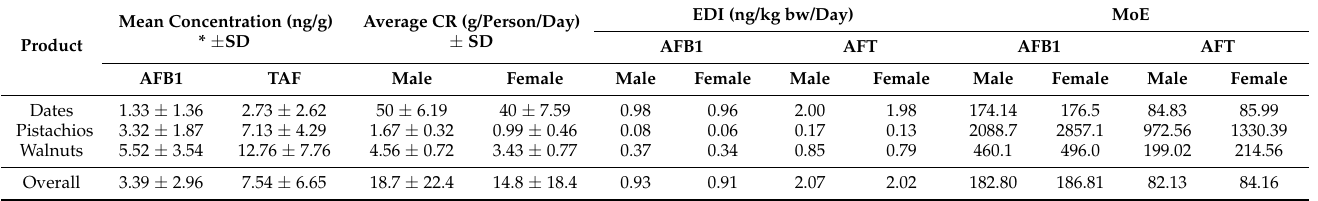
Table 5. The average daily consumption of dates, pistachios, and walnuts, calculated estimated daily intake (EDI) and the margin of exposure (MoE) for AFB 1 and